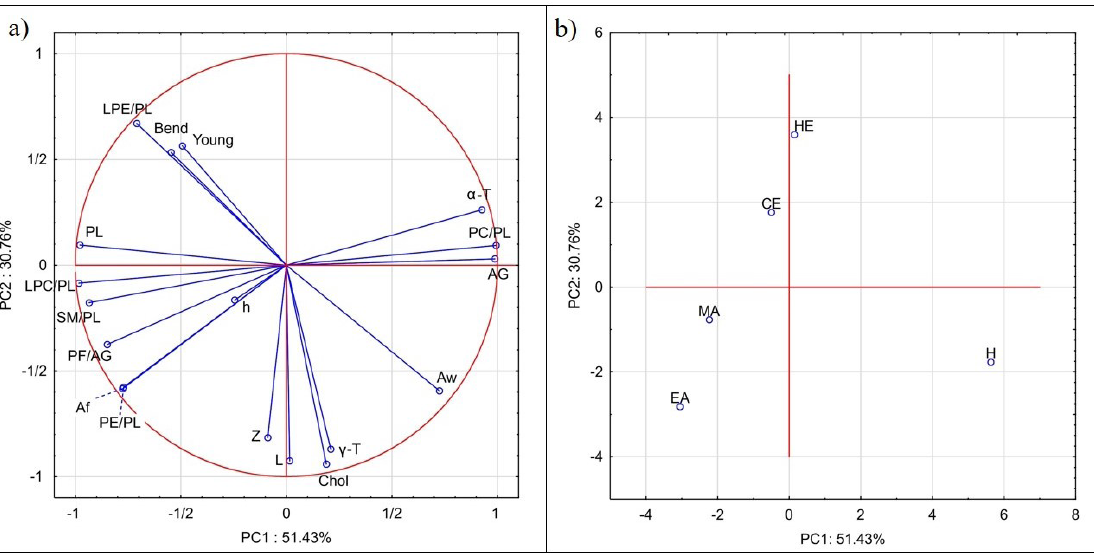
Figure 6: PCA loading plot (a) and score plot (b) of characteristics and nanomechanical properties of liposomes formed from different extracts (Table 3). The data on the composition of extracts were derived from our earlier work [13]. Abbreviations: PL – phospholipids; AG – acylglycerols; Chol – cholesterol; PC/PL – phosphatidylcholine share in total phospholipids; LPC/PL – lysophosphatidylcholine share in total phospholipids; PE/PL - phosphatidylethanolamine share in total phospholipids; LPE/PL – lysophosphatidylethanolamine share in total phospholipids; SM/PL – sphingomyelin share in total phospholipids; PF/AG - polar fraction share in total acylglycerols; NPF/AG – non-polar fraction share in total acylglycerols; α-T - alfa-tocopherol; γ-T - gamma-tocopherol; L – lutein; Z – zeaxanthin; Young –Young modulus;